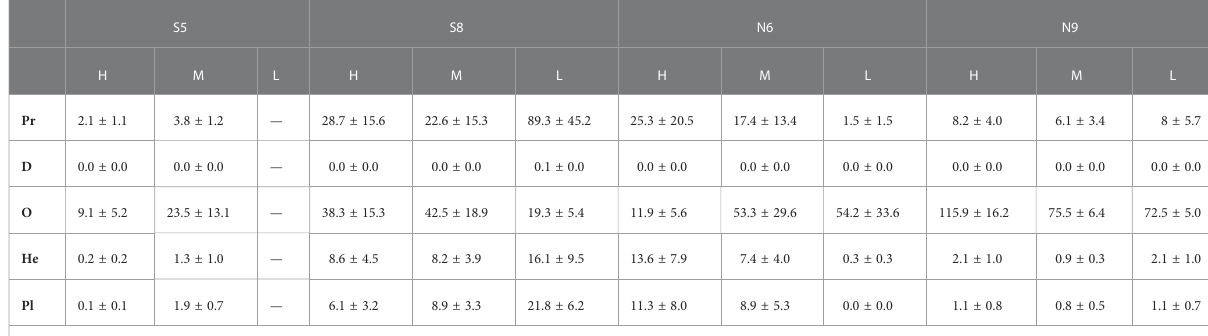
TABLE 4 Biomass of macrobenthic functional groups in the constructed intertidal oyster reef in Yangtze River Estuary during 2016-2017.